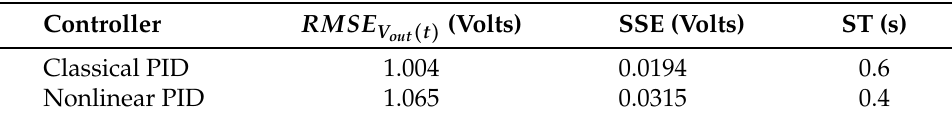
Figure 24. Control input produced by the proposed nonlinear PID controller to manipulate the duty cycle of a PWM signal. Table 8. System performance before the voltage disturbance.